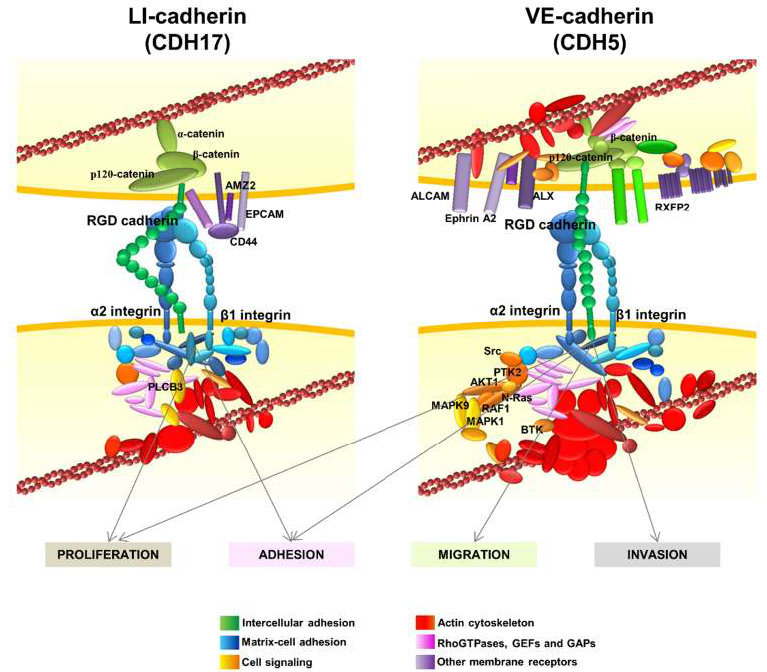
Figure 4. RGD cadherin interactome and integrin signaling in cancer cells. Diagram showing the proteins that specifically bind to CDH17 (left) or VE-cadherin (right) by proteomic analysis and data mining. The most relevant proteins are indicated. Interaction with the RGD cadherins leads to the activation of α 2 β 1 integrin signaling, which promotes proliferation and adhesion in cancer cells, and also migration and invasion in breast cancer and melanoma cells expressing VE-cadherin. Adapted from